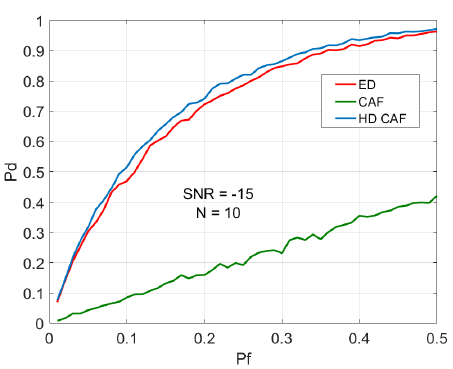
Figure 11. The ROC curves for HD CAF (with uncertainty of spectral density of noise power estimation